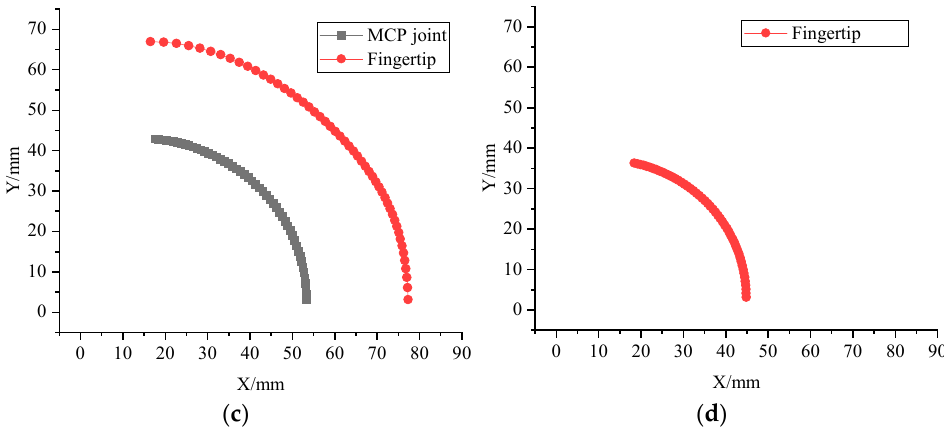
Figure 15. Motion trajectory of different finger simulations. ( a ) Index finger (same size as ring finger); ( b ) middle finger; ( c ) little thumb; ( d ) thumb.